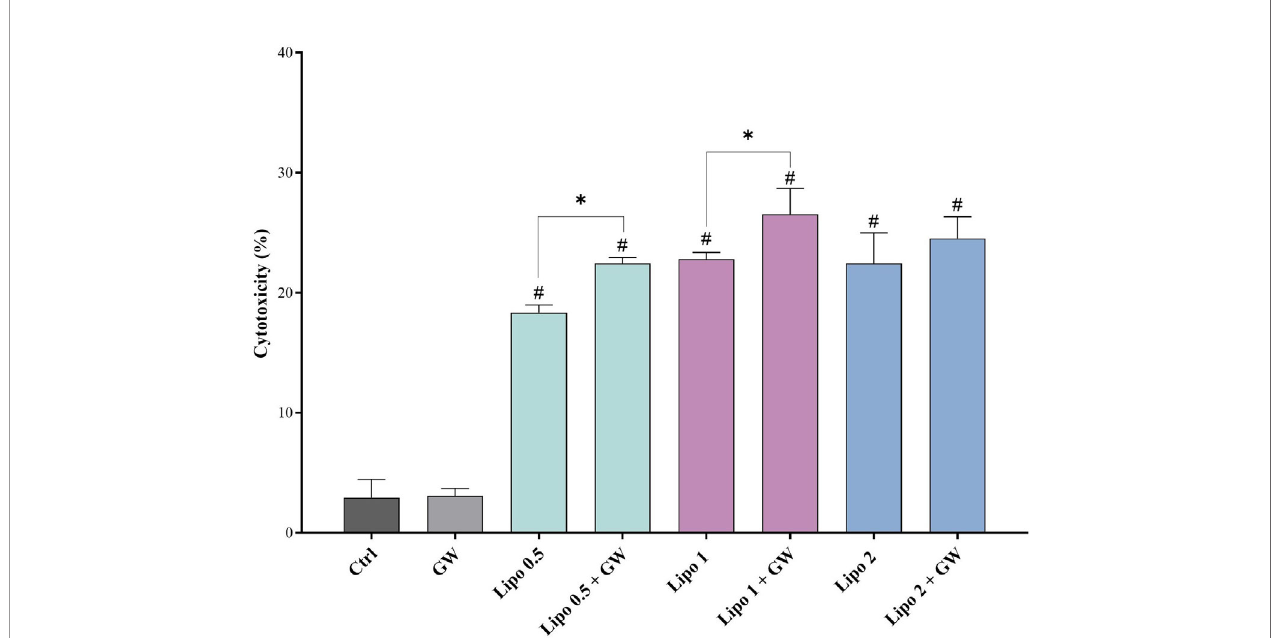
FIGURE 6 | Quantitative analysis of speci fi c cytotoxicity in U937 cells exposed to different concentrations of PLD with/without GW4869 by the LDH release assay. Co-treatment of U937 cells with GW4869 in addition to 0.5 and 1 µM concentrations of PLD could increase its cytotoxicity compared to the corresponding concentrations without GW4869. The combined use of the GW4869 and PLD was able to reduce the required concentration of the drug by half to yield the same cytotoxic effect. Sole GW4869 treatment did not have any signi fi cant effects on the speci fi c cytotoxicity of U937 cells compared to the untreated control (P > 0.05). Ctrl, untreated control; GW, GW4869-treated; Lipo 0.5, 0.5 µM PLD; Lipo 0.5 + GW, 0.5 µM PLD with GW4869; Lipo 1, 1 µM PLD; Lipo 1 + GW, 1 µM PLD with GW4869; Lipo 2, 2 µM PLD; Lipo 2 + GW, 2 µM PLD with GW4869. # Signi fi cantly different compared to the control group (P < 0.05), *signi fi cantly different compared to the same concentration with/without GW4869 (P <